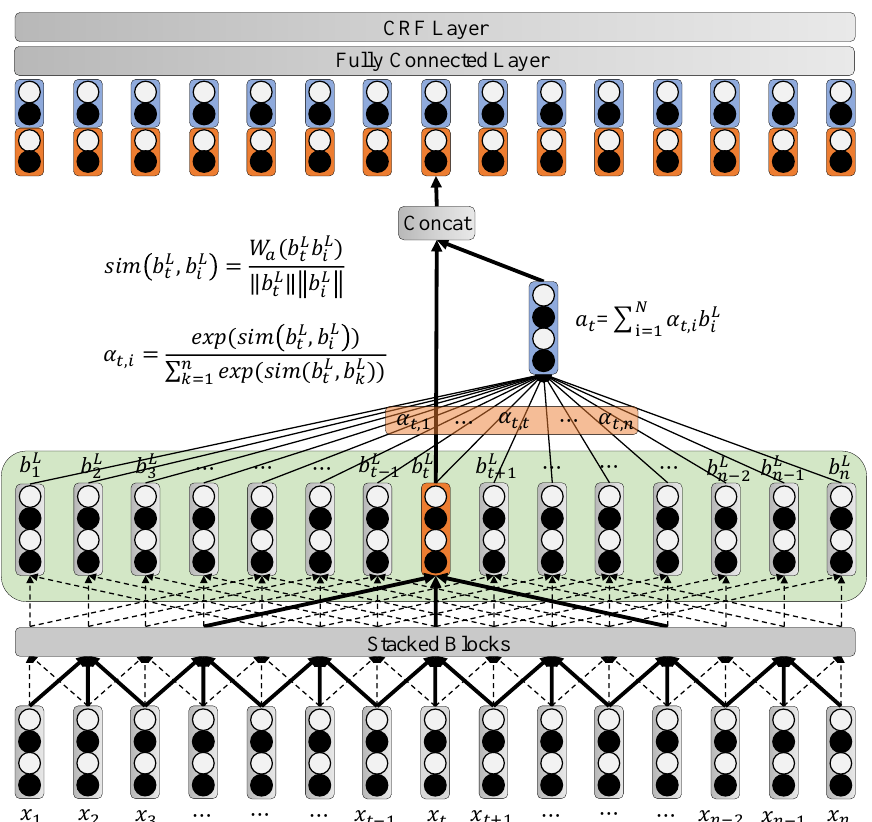
Figure 3. Attention-based ID-CNN-CRF architecture. We stacked 4 Dilated CNN blocks, each as shown in Figure 5. To simplify the drawing, we used Stacked Blocks to represent all the layers in the middle. For the output b L at position t (the orange unit with four circles), we calculated its similarity with t all the output units and took them as weights { α t ,1 ,..., α t , i ,..., α t , n } . The output was multiplied by the corresponding weight and then summed as the attention vector a t . Concatenate a t with b L full connection layer to map it into the category space. Finally, the optimal tag sequence was obtained by